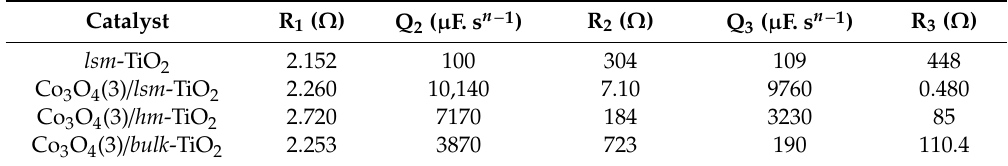
The EIS parameters of pure lsm -TiO 2 , Co 3 O 4 (3) / lsm -TiO 2 , Co 2 O 3 (3) / hm -TiO 2 , and Co 2 O 3 (3) / bulk -TiO 2 catalysts obtained through fitting EIS spectra measured at η = 500 mV to an equivalent circuit.